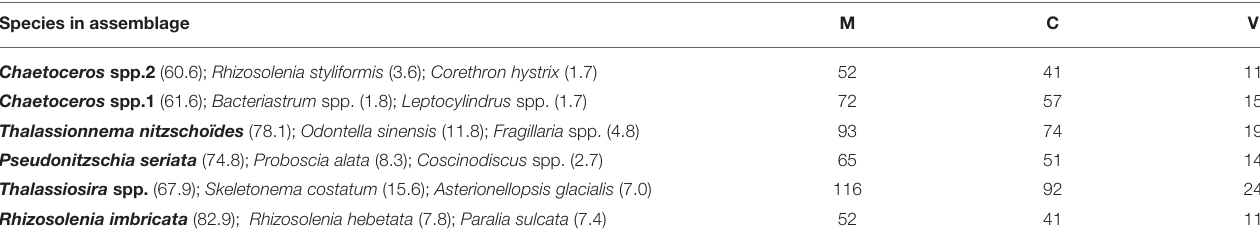
On the left part, the in-situ assemblages are described with indicator species (in bold) and secondary diatom species with their attributed Indicator Value according to Dufrêne and Legendre (1997) from CPR diatom data in parentheses. On the right part, M is the number of coincident measures associated with this assemblage; and C and V are respectively the number of coincident measures for calibration (80% of M) and validation (20% of